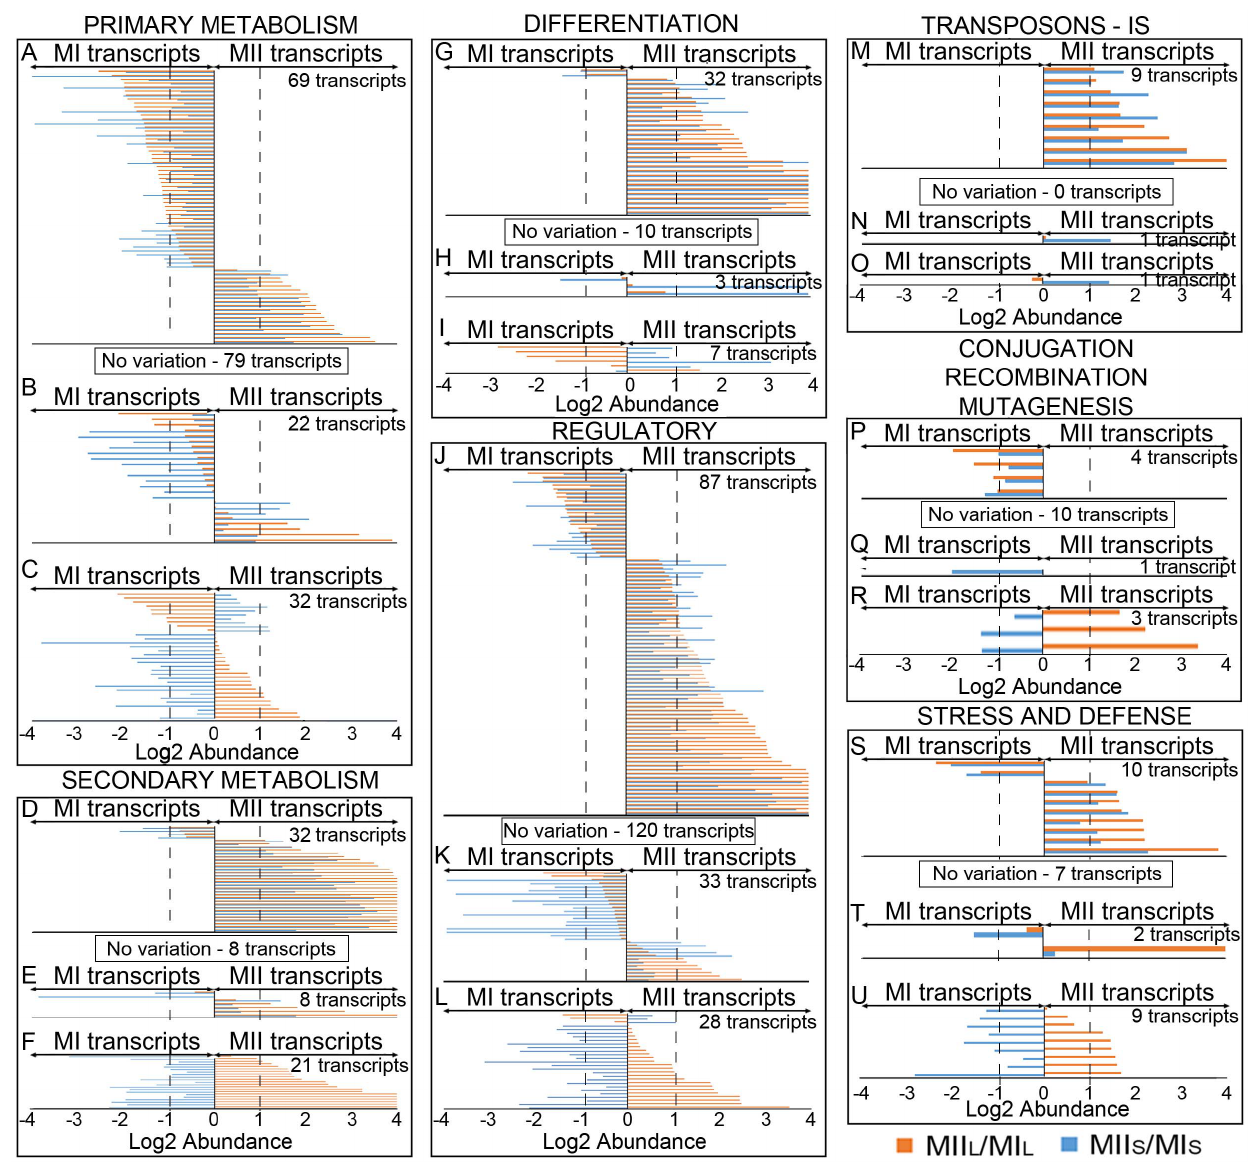
Figure 4. Abundance values of transcripts quantified in solid and liquid cultures (1901 in total) and grouped into functional categories . Abundance values (average of log2 MII/MI from three biological replicates) and transcripts with significant variations in MIIL and/or MIIS (log2 abundance greater than 6 1) are shown. Transcripts without significant (log2 abundance within the 6 1interval) are indicated into squares and labeled as ‘‘No variation’’. Functional categories: primary metabolism (DNA/RNA replication, aerobic and anaerobic energy production, glycolysis and glyconeogenesis, pentose phosphate pathway, amino acid metabolism, nucleotide metabolism, translation, protein folding, RNA/protein processing, nucleases/RM methylases); secondary metabolism (secondary metabolite synthesis); differentiation (TTA bldA targets, Bld and Whi proteins); regulatory genes (transcriptional regulators, kinases, other regulatory genes); transposons - insertion sequences; conjugation, recombination, mutagenesis; stress and defense proteins. Dashed lines indicate the limit for considering abundance variations significant (log2 abundance 6